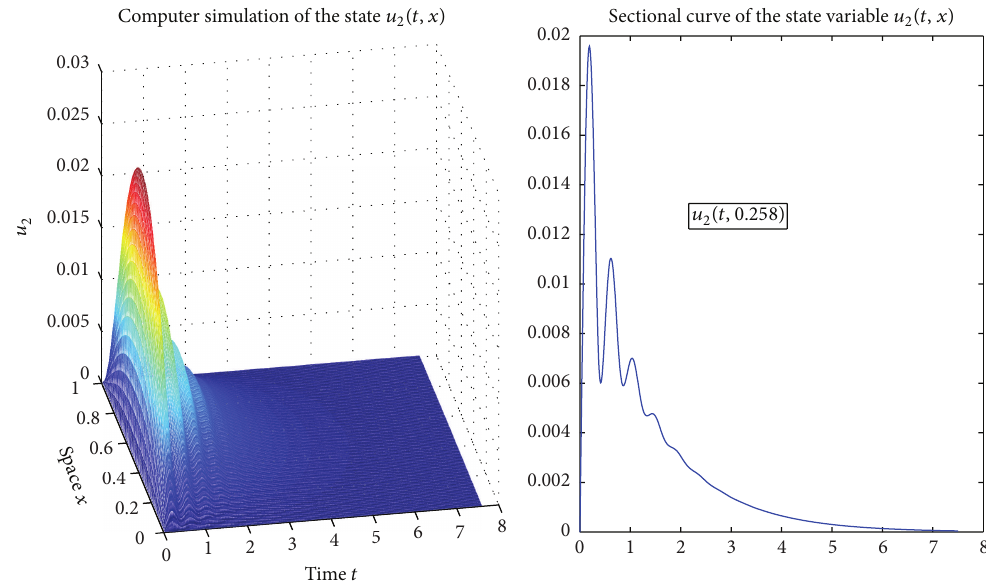
Sectional curve of the state variable u 2 ( t , x )